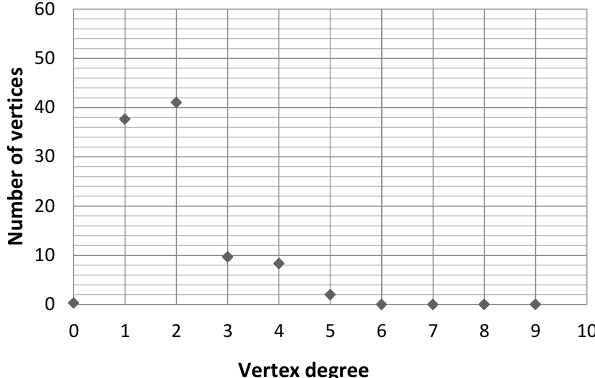
Figure 12. The distribution of vertices degrees after removing STW and BGC nodes and one from three of fifth degree nodes (averaged data).